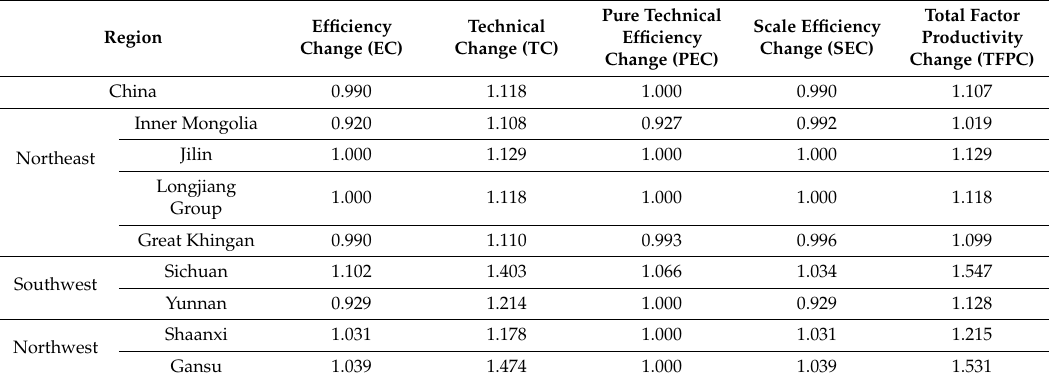
Table 3. TFP variation of key state-owned forestry enterprises with space. Efficiency Technical Region Change (EC) Change